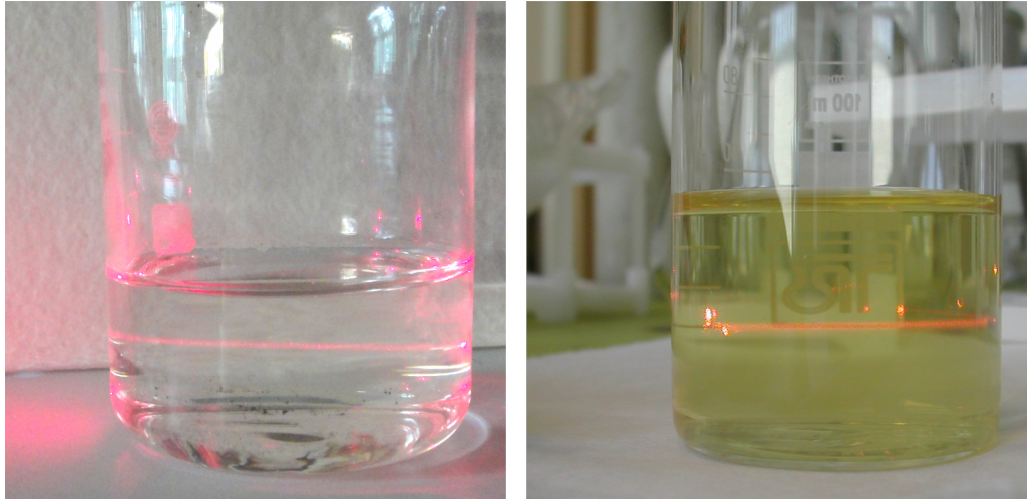
Figure 5. Light scattering (laser beam, 650 nm) by the sulfuric acid solution after a single cycle of the cellulose hydrolysis ( left ) and by the supernatant obtained after MCC mild mechanical treatment and centrifugation ( right